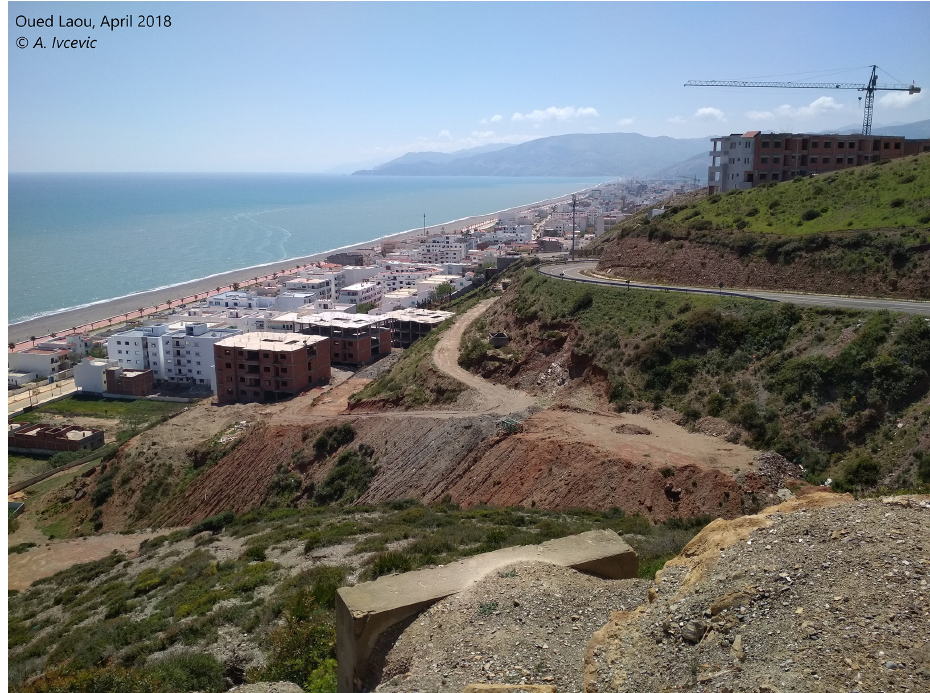
Figure 2. The region of north Morocco, which has experienced a high increase in touristic